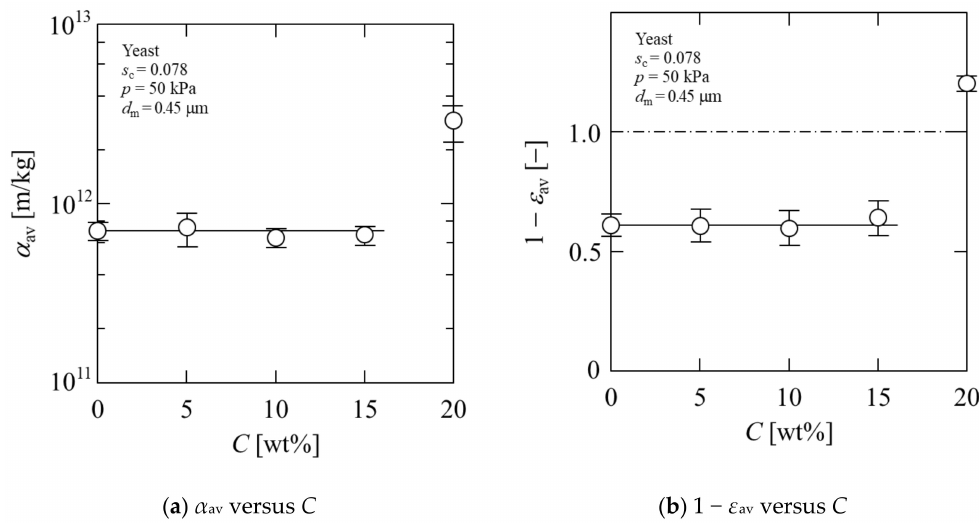
Figure 4. Relationship between cake characteristics and ethanol concentration: ( a ) α av versus C ; ( b ) 1 − ε av versus C